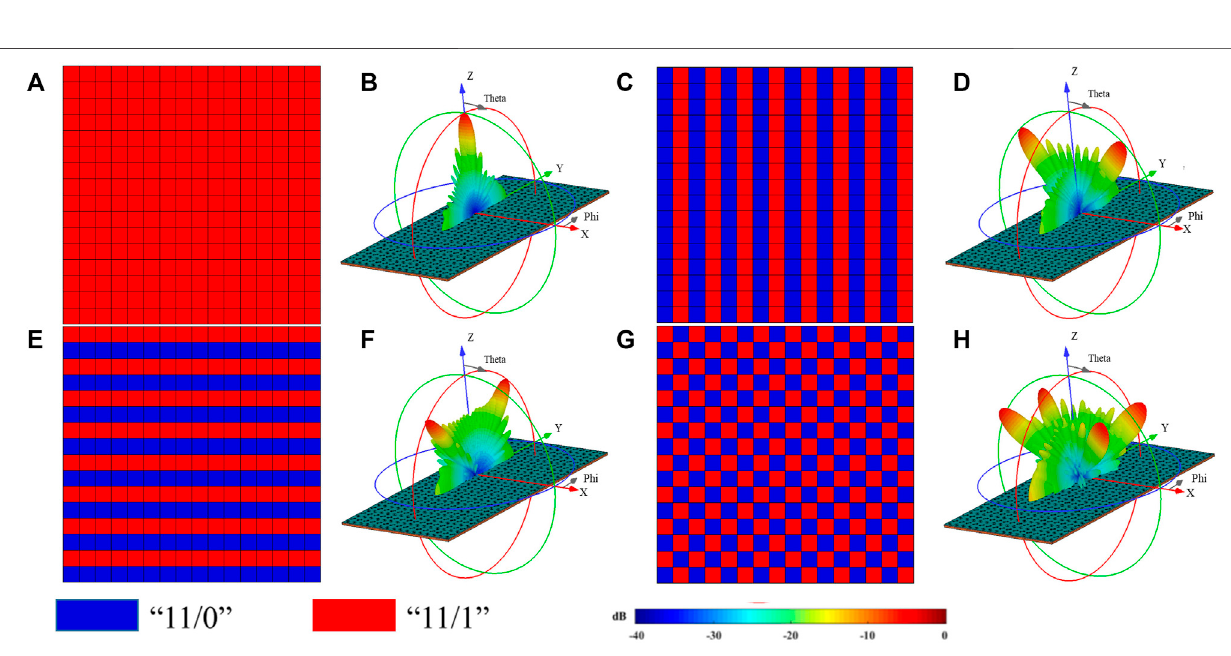
Frontiers in Materials |